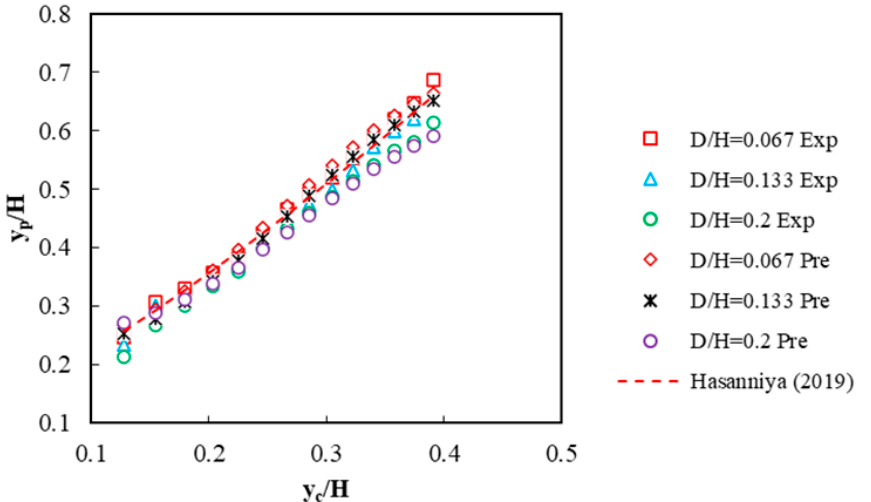
Figure 9. Variation of relative pool depth versus relative critical depth.